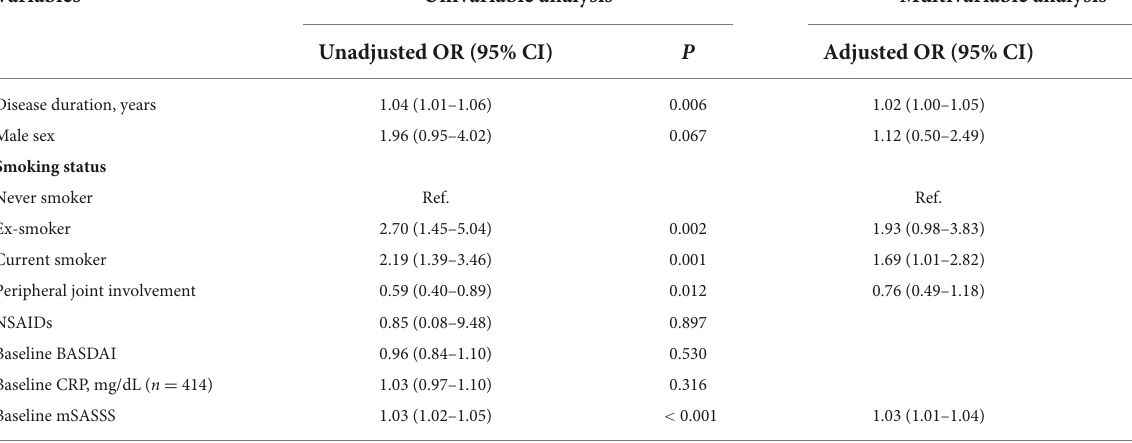
TABLE 4 Factors associated with mSASSS progression rate > 1